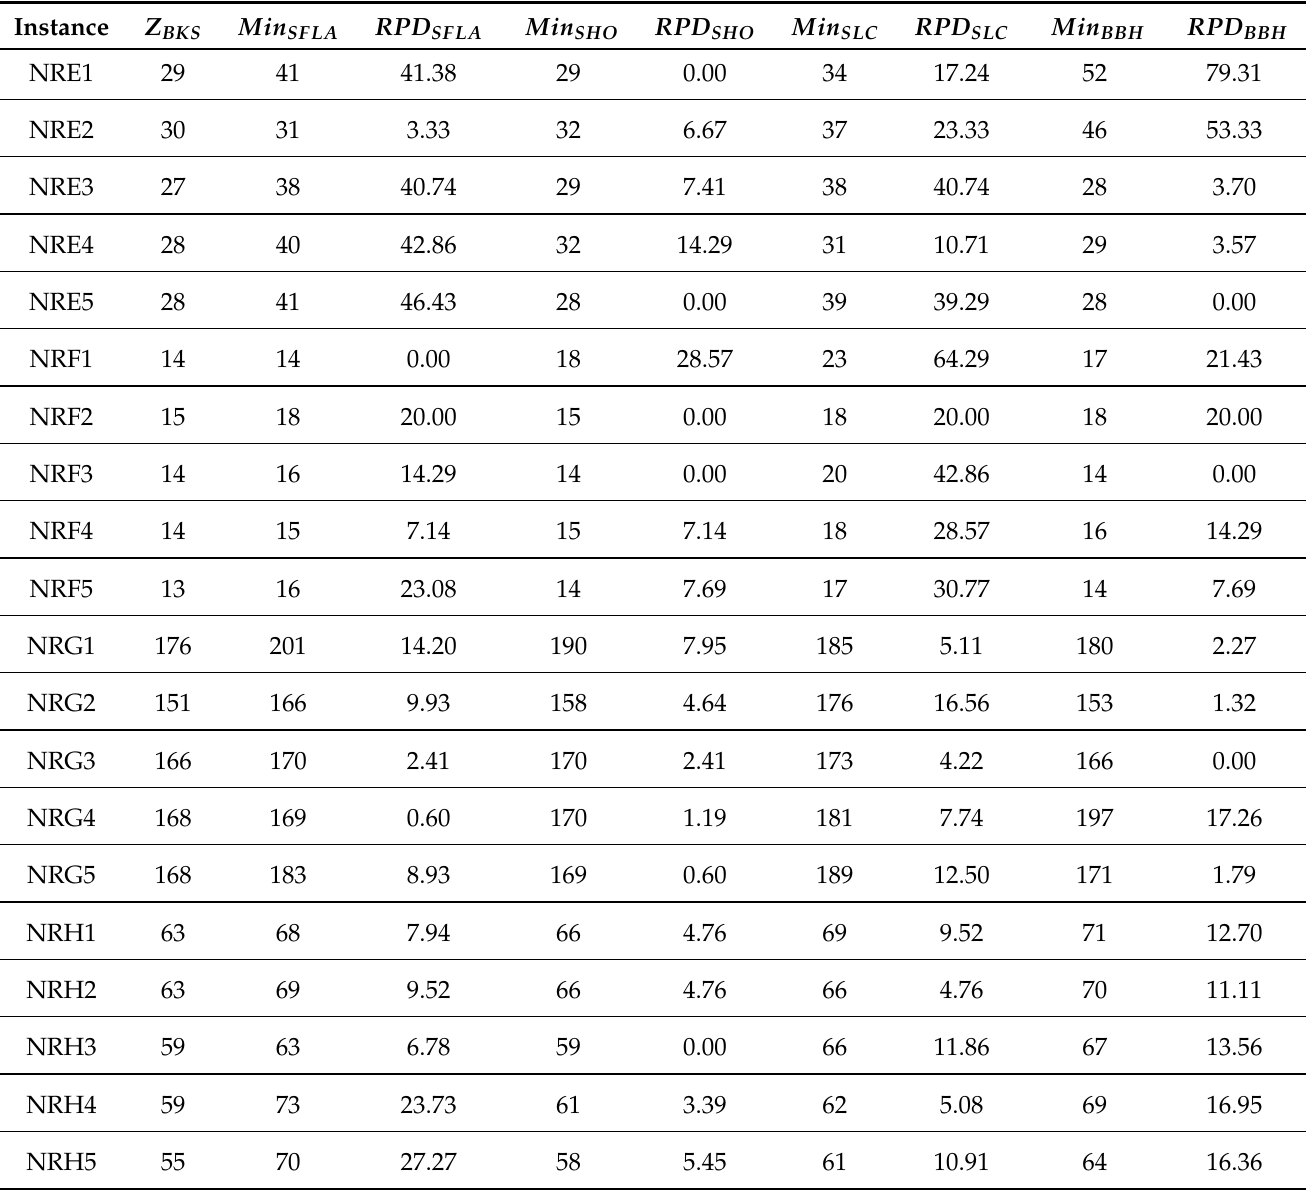
Table 2. Results comparison for standalone